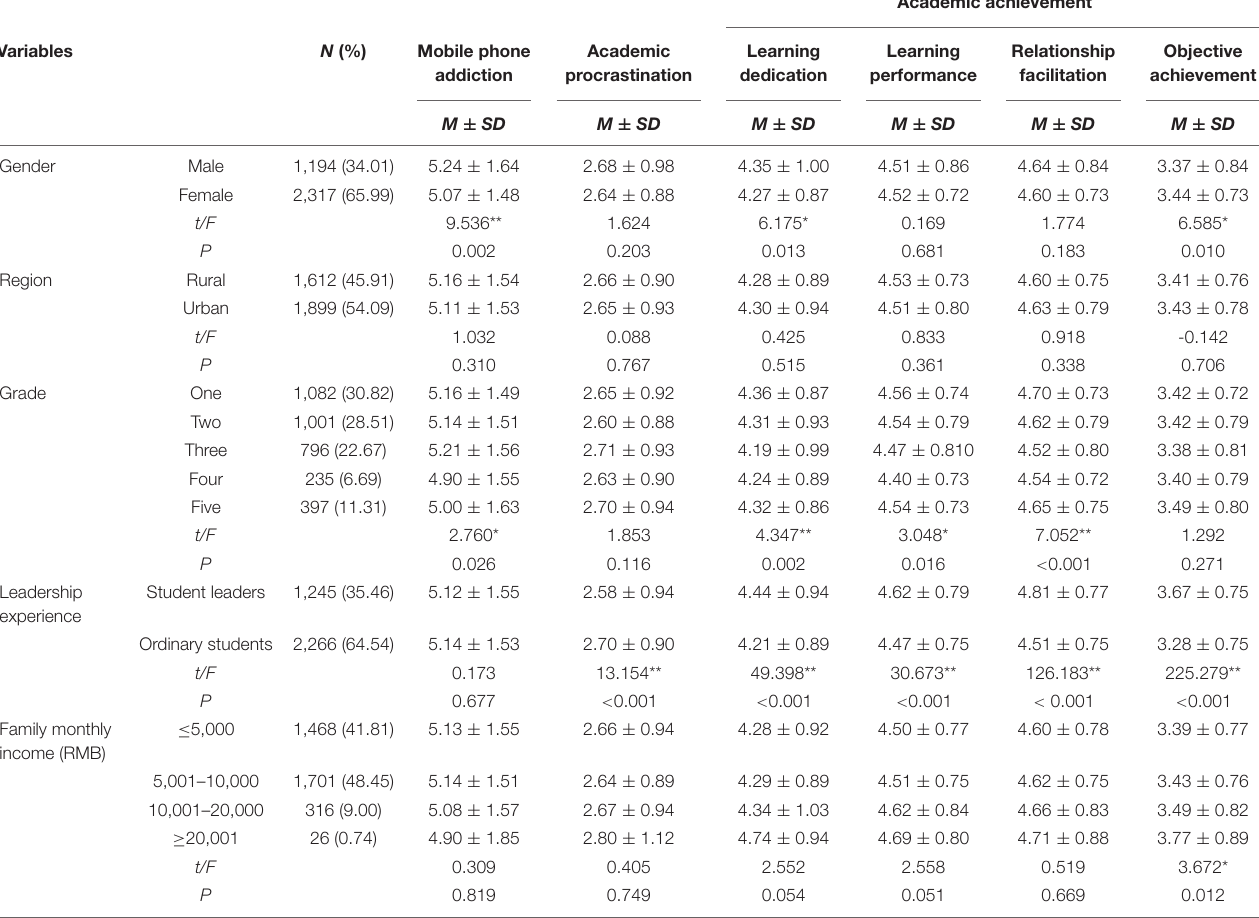
TABLE 2 | Variance analysis and description of each